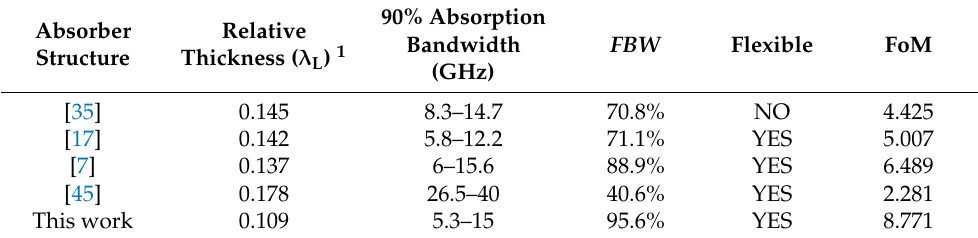
Table 1. Comparison with other transparent broadband absorbers.